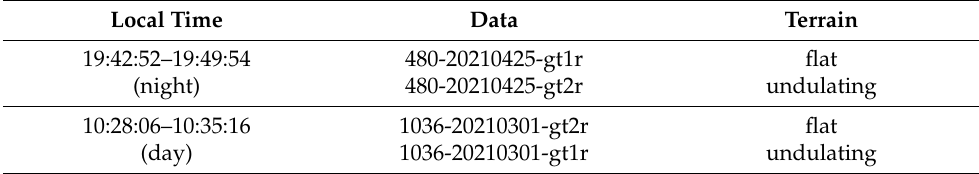
Table 1. The ICESat-2 data acquisition time and terrain details.